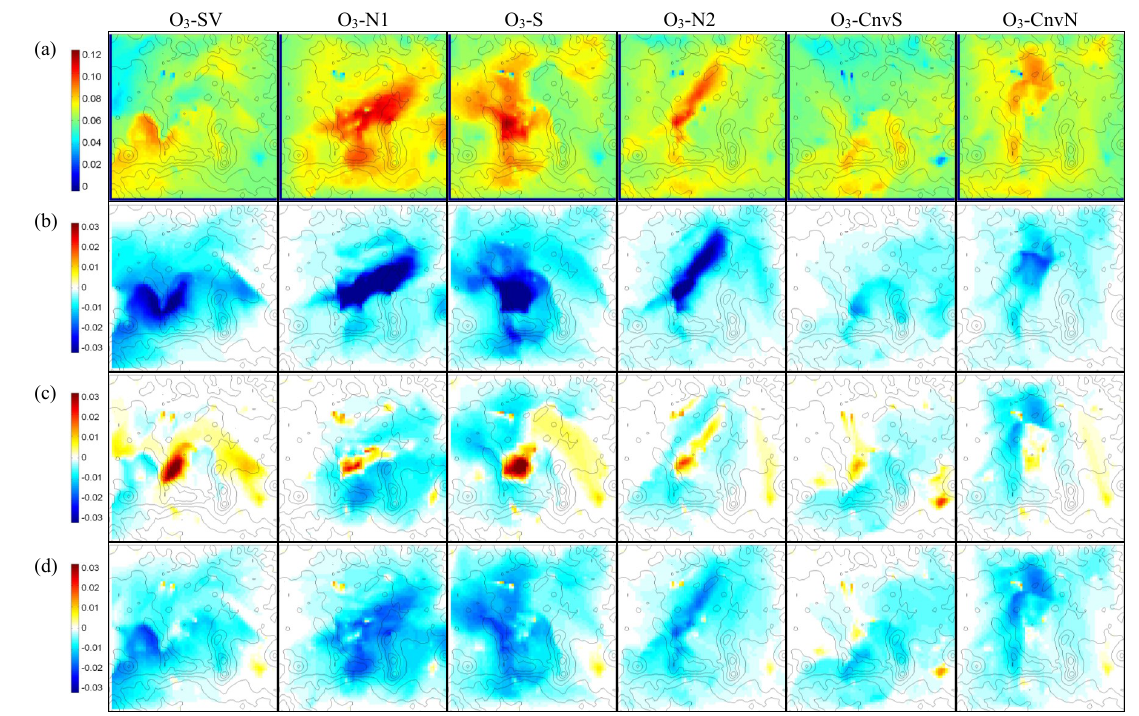
Fig. 11. Spatial distribution of peak ozone changes due to the changes in emissions under different meteorological conditions. (a) Peak ozone concentration in the base case, (b) ozone change with 50% VOC, (c) ozone change with 50% NO x , and (d) ozone change with 50% VOC and NO x . Snapshots were taken at peak ozone hours, units are in